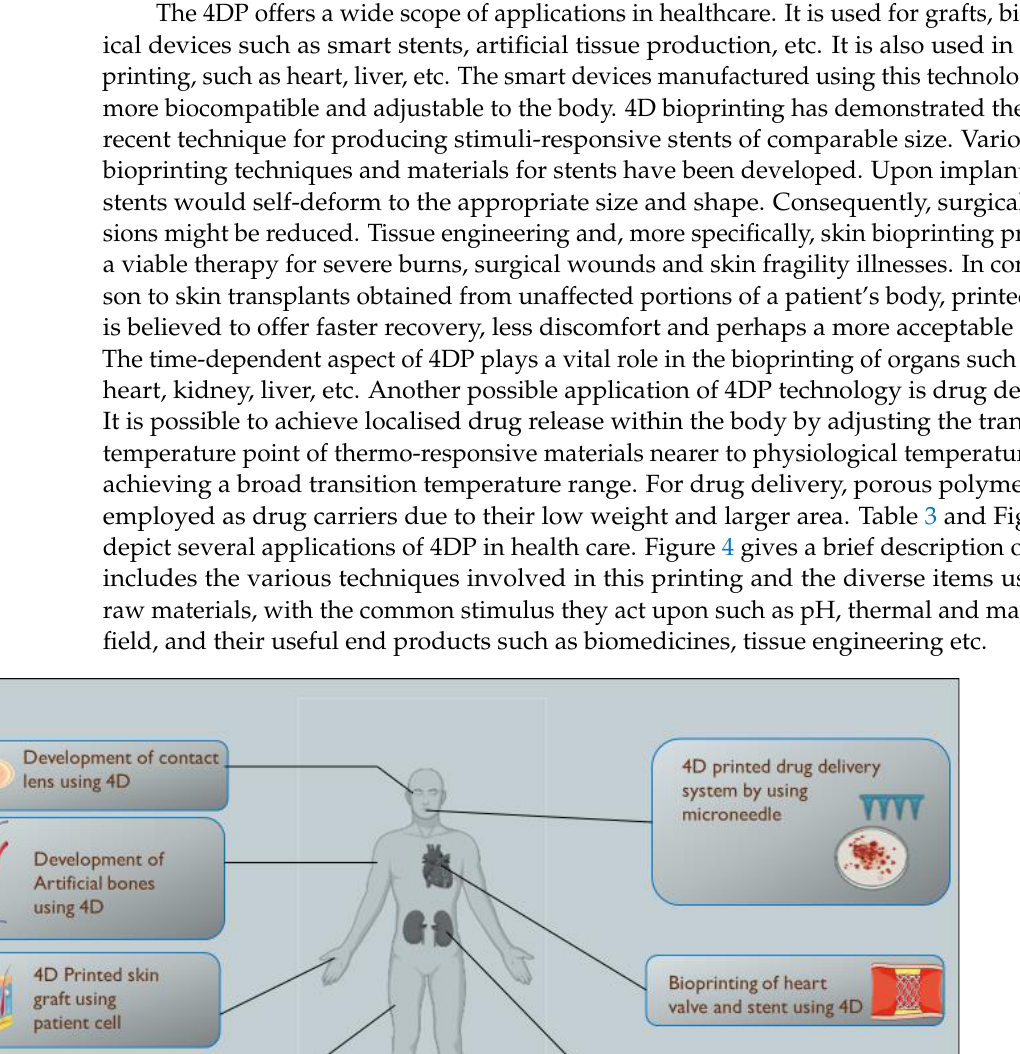
Figure 4. A brief description of 4D printing technology which includes the various techniques in- volved in the printing. The various materials used as raw materials with the common stimulus they